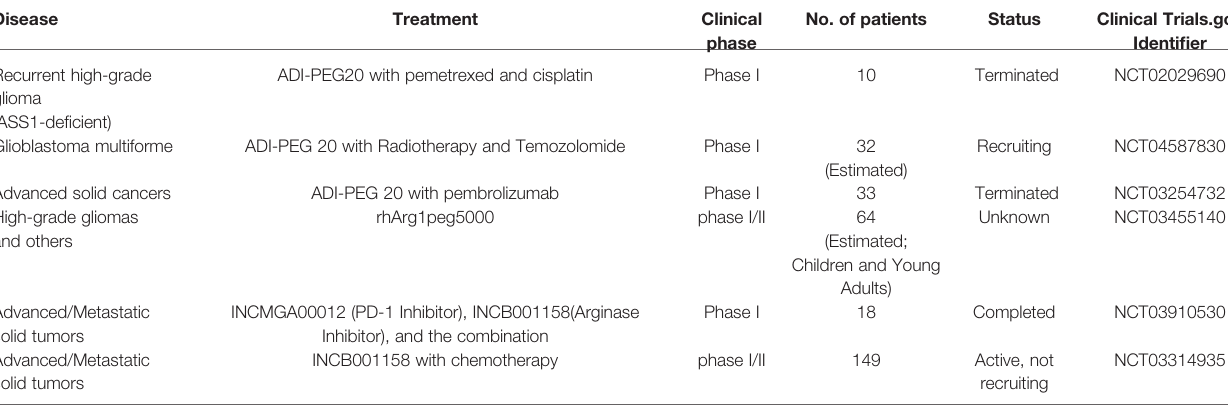
TABLE 1 | Clinical studies on arginine depletion in glioma treatment.